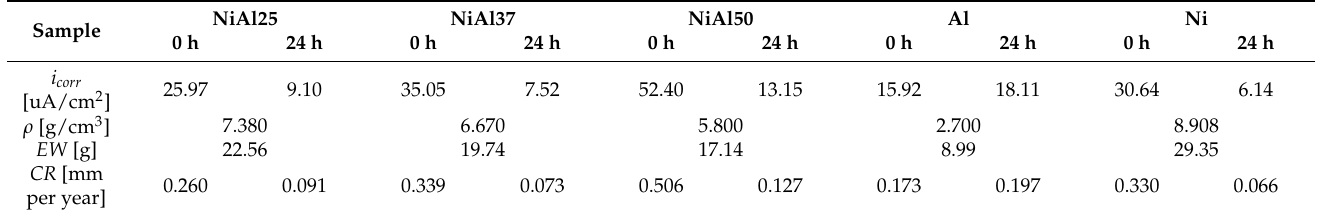
Table 2. Corrosion current, EW, density and corrosion rate obtained from polarization curves.